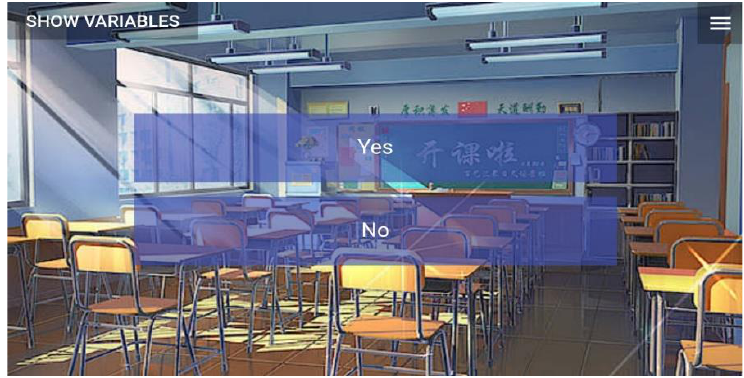
Picture 3. Branch Story in the game.